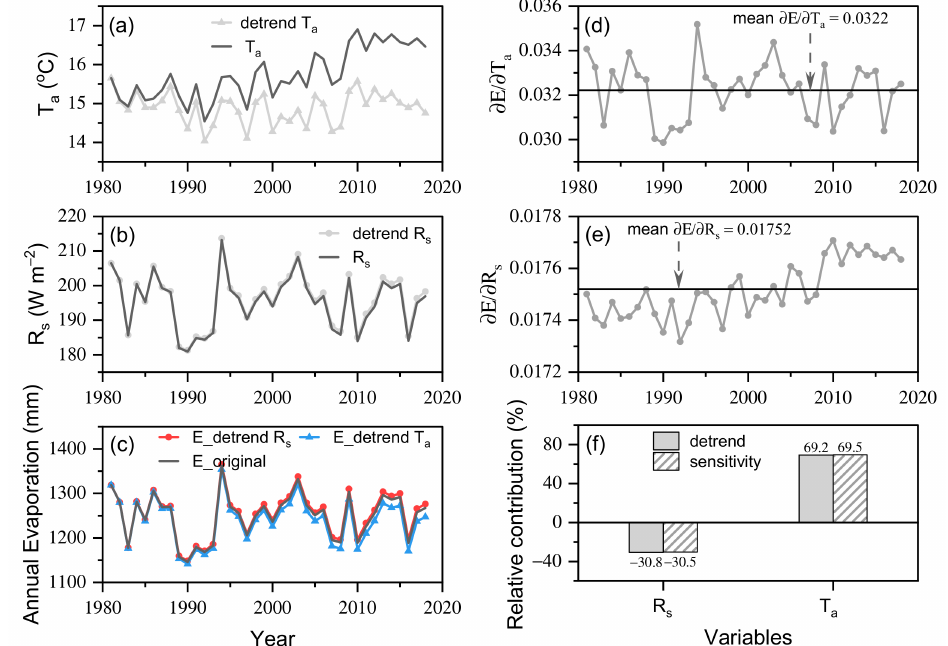
Figure 9. Interannual variations of original annual averaged meteorological variables and its detrended series: ( a ) air temperature T a and ( b ) incoming solar radiation R s . ( c ) Variations of annual total evaporation estimated by the modified JH method using the original inputs and detrend inputs. The “E_original” line means lake evaporation is calculated by using original data. The “E_detrend R s ” line means lake evaporation is calculated by using detrend R s and original T a . The “E_detrend T a ” line means lake evaporation is calculated by using detrend T a and original R s . Variations of partial derivatives of ( d ) T a and ( e ) R s . ( f ) Relative contributions of R s and T a to the annual total